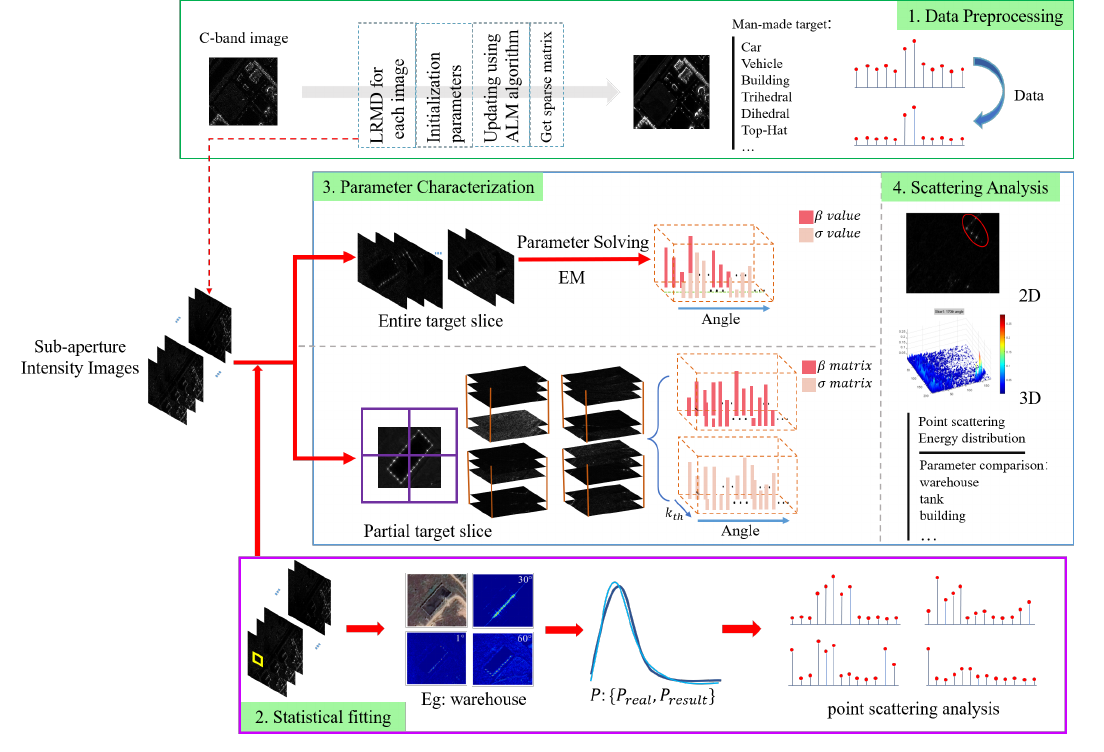
Figure 3. The detailed implementations of using algorithm.